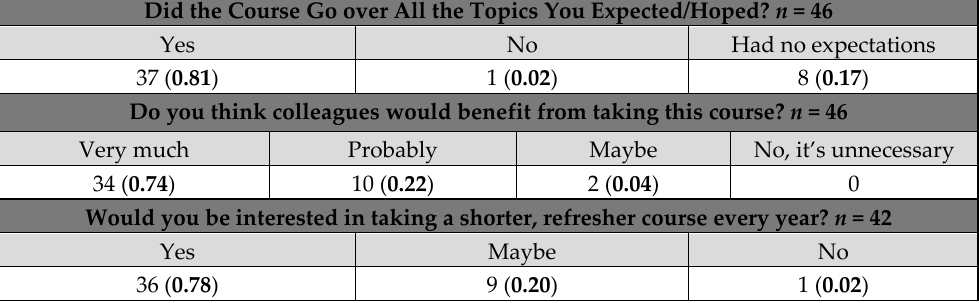
Table 2. A total of 42 participants answered questions about overall satisfaction with the training course. The majority reported that the course covered what they expected (81.0%), that their colleagues could benefit from it (73.8%), and that they would be interested in taking a yearly refresher course (76.2%).